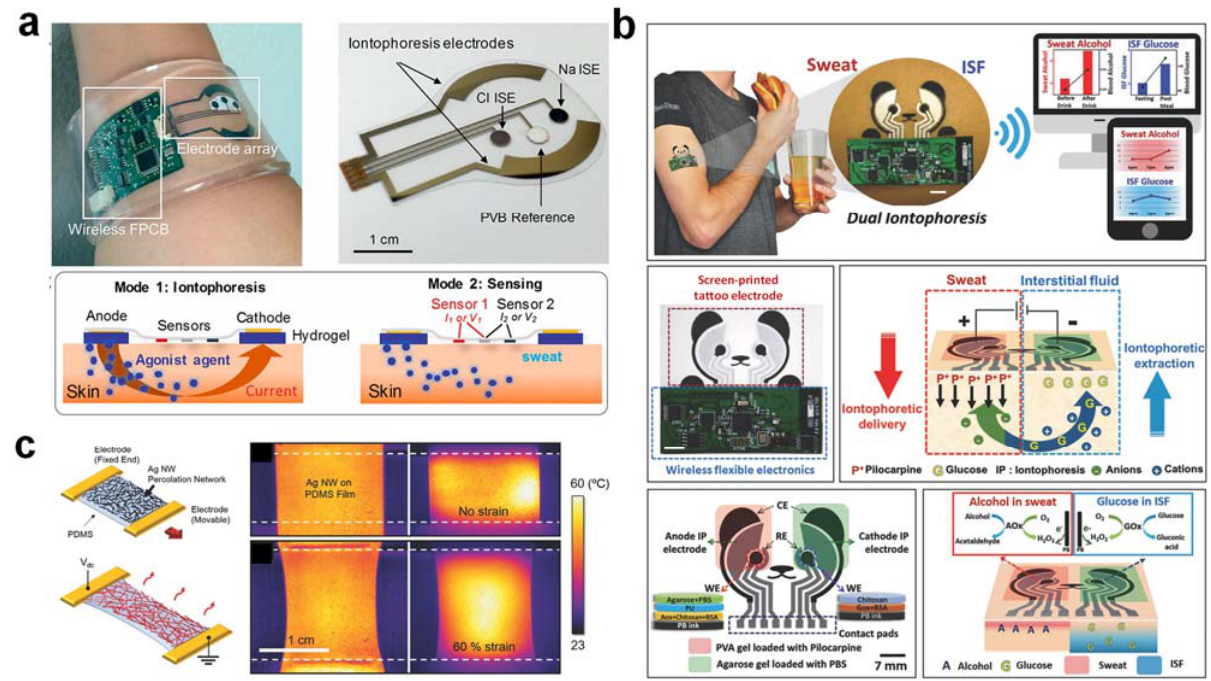
Figure 4. ( a ) A fully integrated wearable sweat ‐ extraction and analysis platform for cystic fibrosis and glucose monitoring. ( b ) Monitoring of sweat (iontophoresis) and interstitial fluid (reverse iontophoresis) with a single wearable biosensor system at the same time. ( c ) A highly stretchable and transparent nanowire heater for wearable electronics applications. The figures are reprinted with permission from ref [12,33,35].